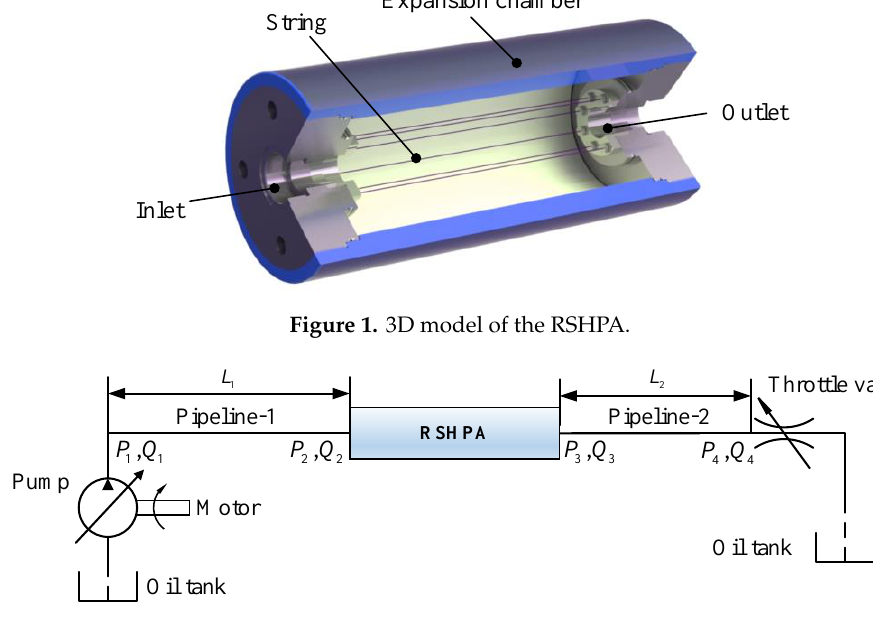
Figure 2. Schematic diagram of a hydraulic system with the resonant string-based hydraulic pulsation attenuator (RSHPA).